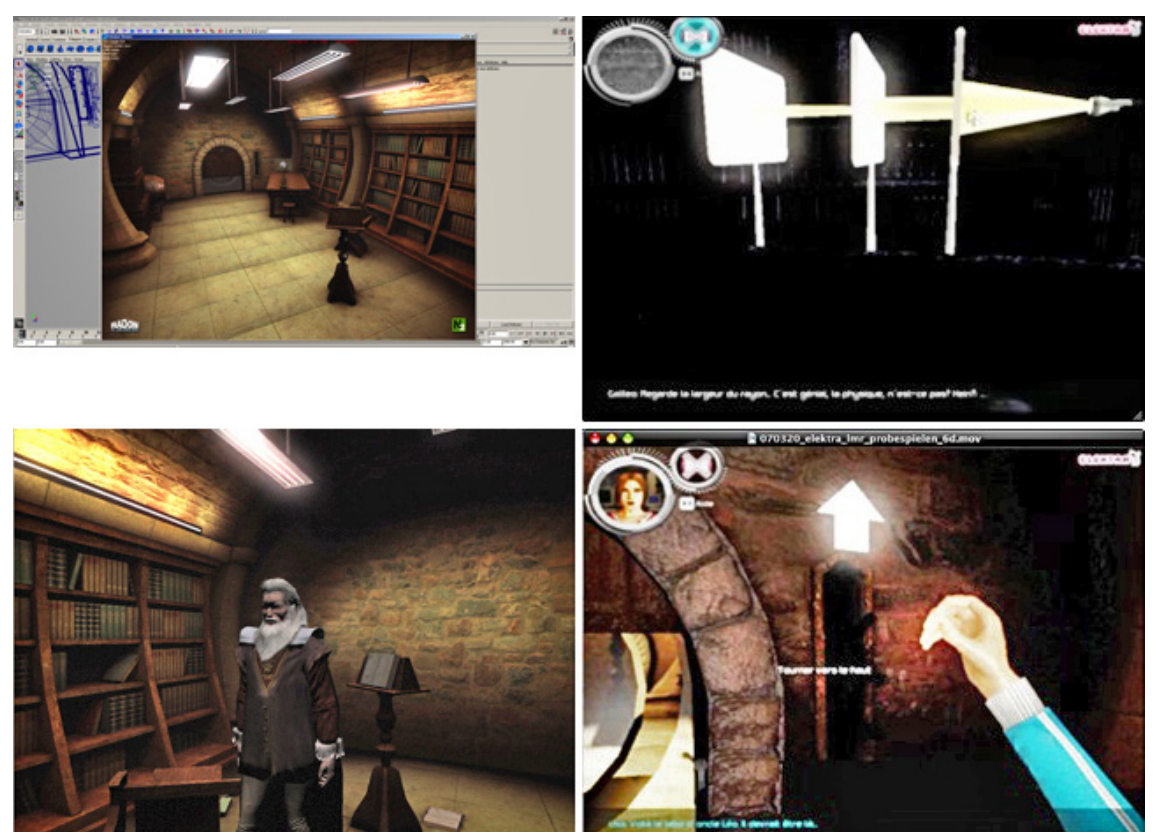
Figure 3. Design of Elektra with intrinsic support in the form of a pedagogical agent. Measurement Instruments Background